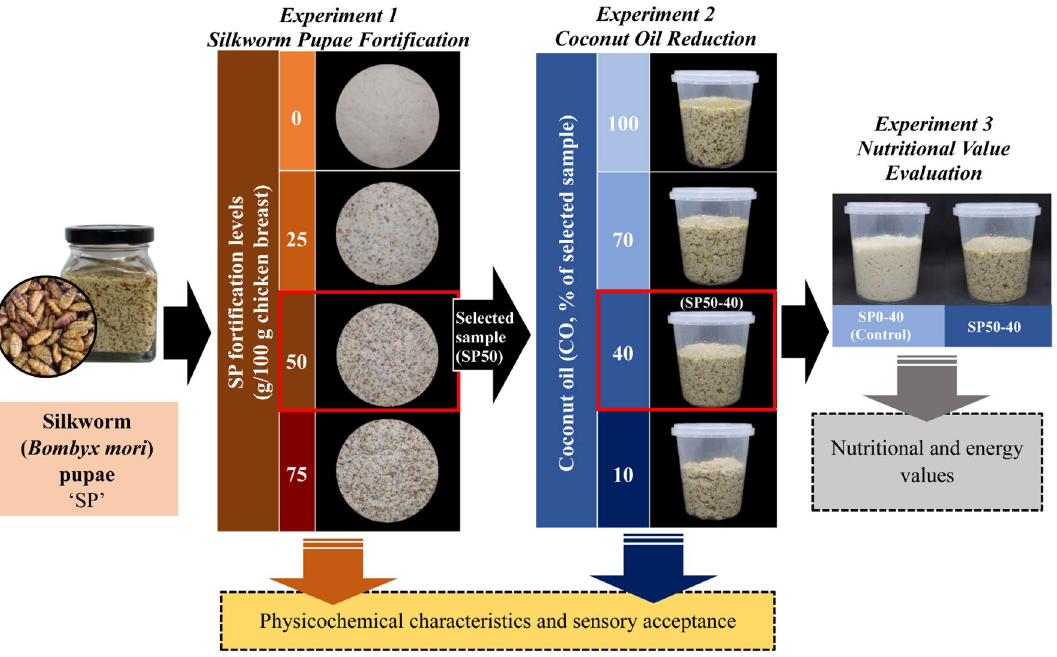
Figure 1. Scheme of experimental design for development of silkworm ( Bombyx mori ) pupae-fortified chicken bread spread on characteristics and nutritional